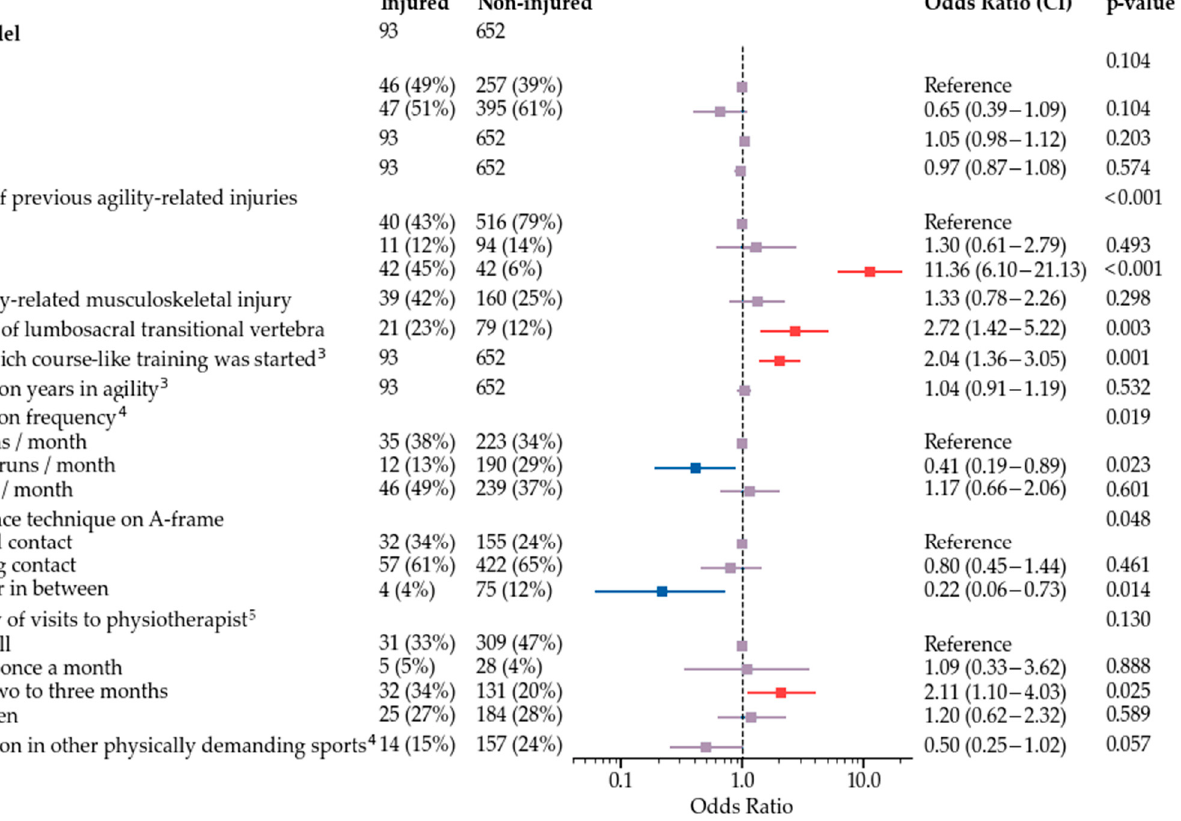
Figure 2. Training frequency model for odds of agility-related injury during 2019. 1 For a one centimeter increase, the odds increase by OR. 2 For a one year increase, the odds increase by OR. 3 For a one year increase, the odds increase by OR. 4 Routines during the three-month period preceding injury in injured dogs and during 2019 in non-injured dogs. 5 Routines during the one-year period preceding injury in injured dogs and during 2019 in non-injured dogs.